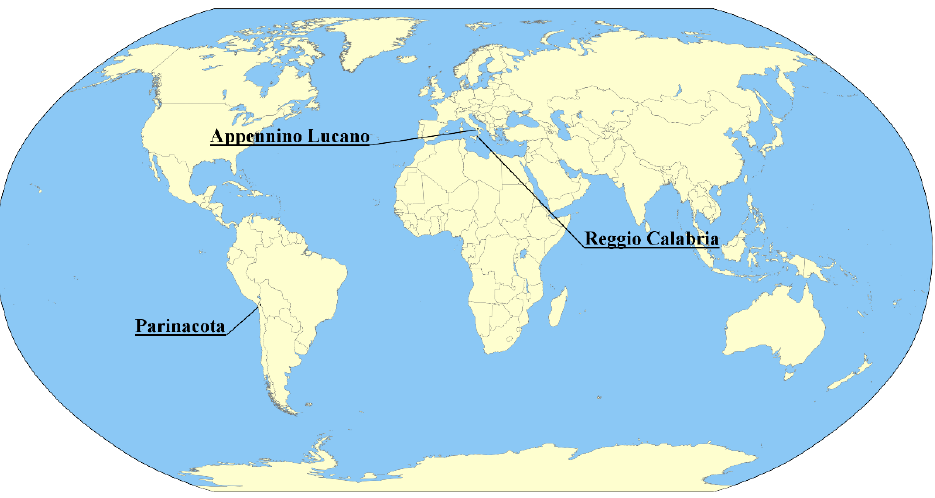
Figure 3. Test cases locations.